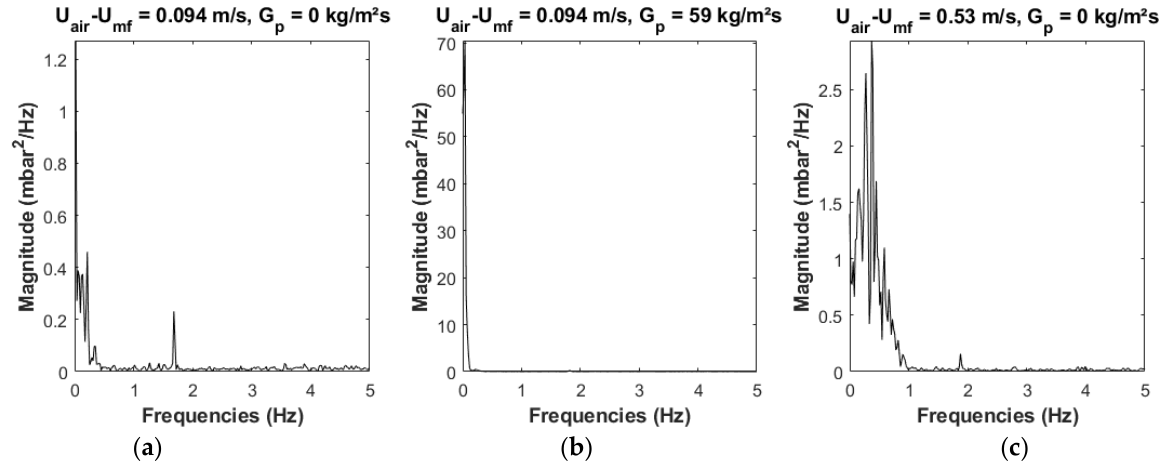
Figure 8. Three spectra obtained with the P tot pressure signal with various experimental configurations of the air velocity and the solid mass flux, respectively ( a ) 0.094 m/s and 0 kg/m²s, ( b ) 0.094 m/s and 59 kg/m²s, and ( c ) 0.53 m/s and 0 kg/m²s.